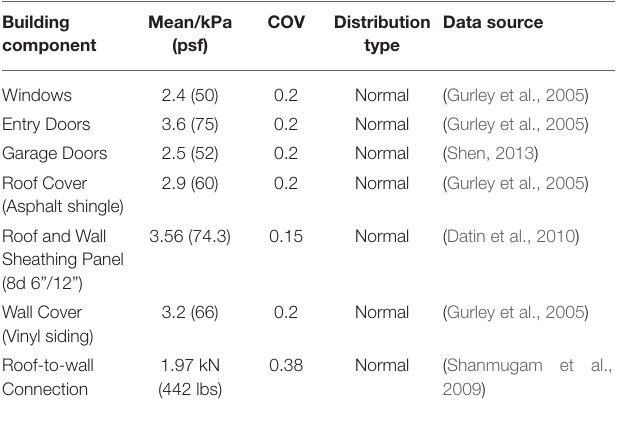
TABLE 2 | Mean value and Standard Deviations of structural capacities for the house